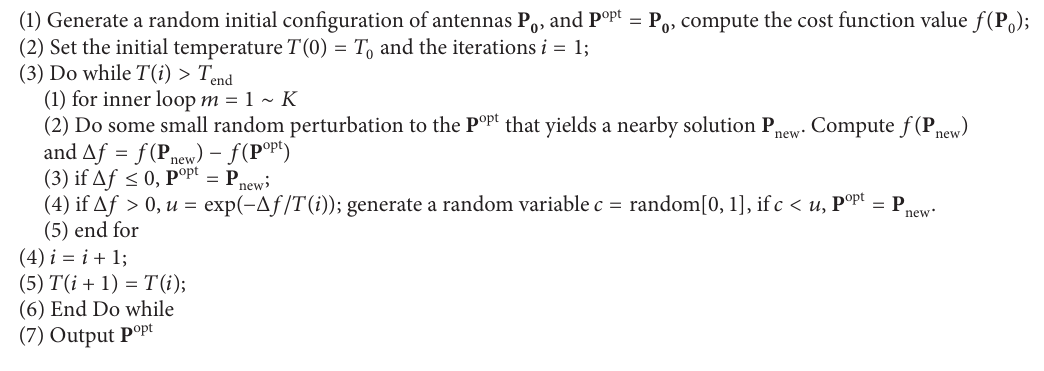
Algorithm 1: Process of SA algorithms.